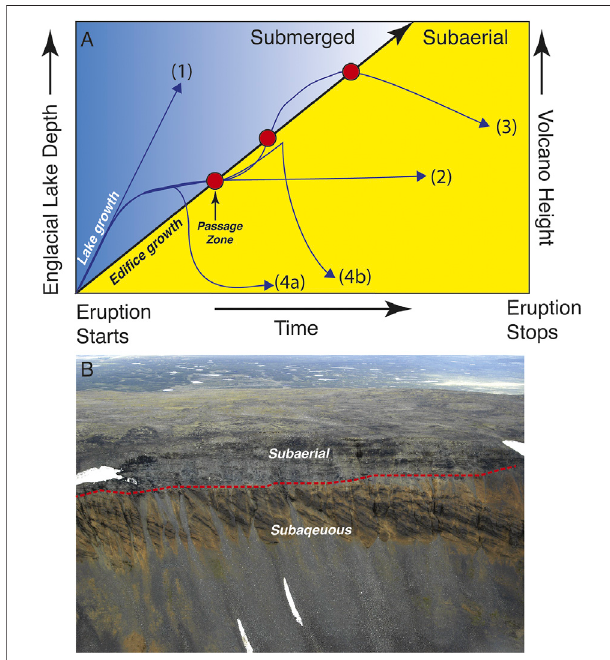
FIGURE 8 | (A) Schematic diagram showing competing rates of growth for an eruption-generated, englacial lake and the growth ofthe corresponding volcanic edi fi ce. The numbered lines show different paths for the changing lake depth relative to edi fi ce growth: (1) lake depth always outpaces growth of edi fi ce; (2) lake depth initially outpaces edi fi ce but eventually stagnates;(3)relative lakedepthandedi fi ce growthrepeatedlyswitch;(4)lake depth initially outpaces edi fi ce growth, then slows allowing edi fi ce to become emergentpriortocataclysmic drainingoflake. (B) Example ofapassagezone from Kima ‘ Kho tuya, northern British Columbia (Russell et al.,